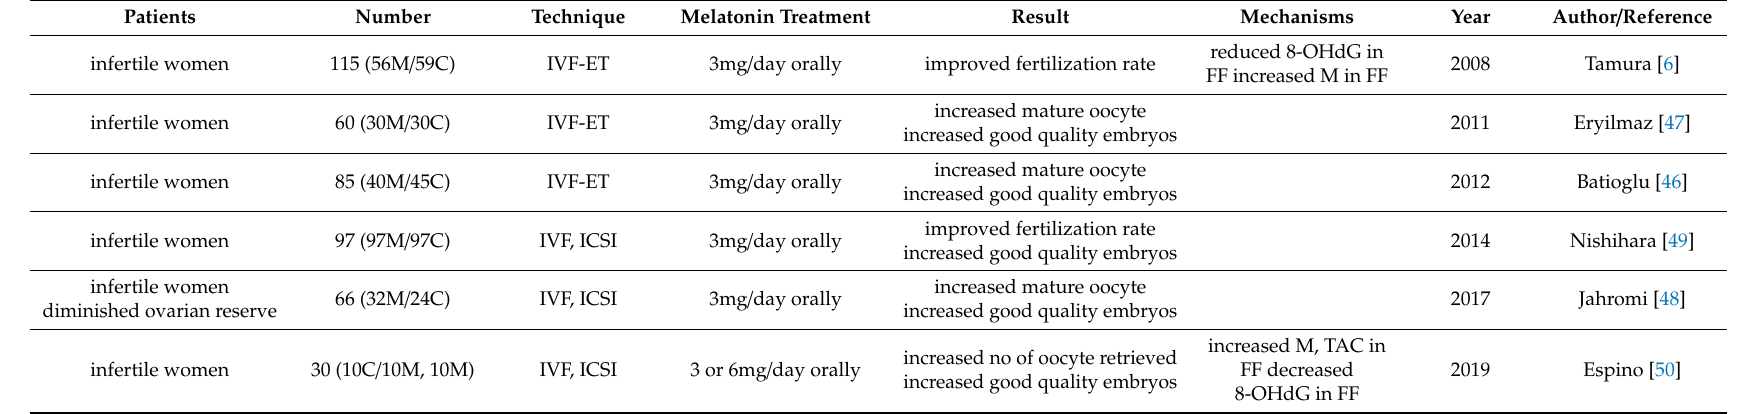
Table 1. E ff ects of melatonin on assisted reproductive technology in humans (in vivo study). M: melatonin; C: control; IVF: IVF: in vitro fertilization;